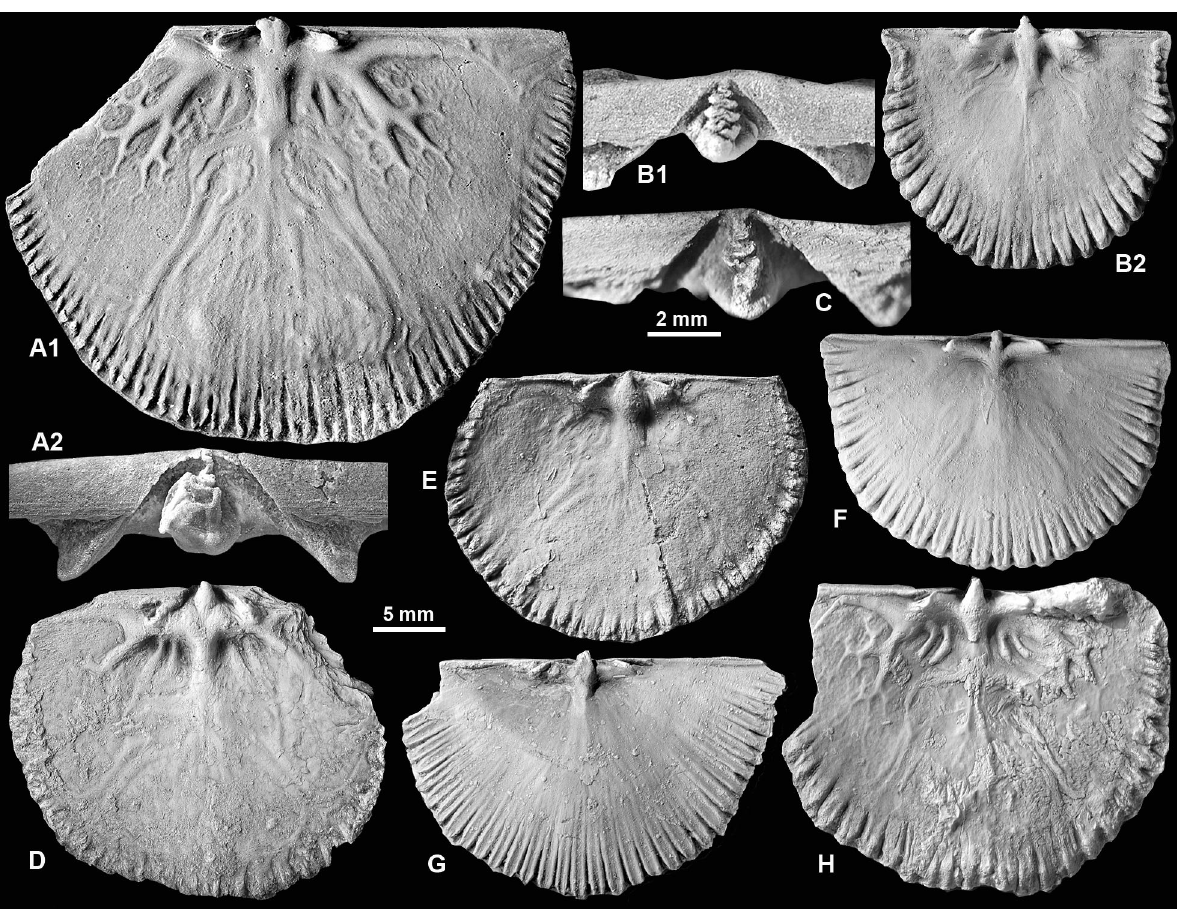
Fig. 4. A1 , A2 , Cyrtonotella kuckersiana kuckersiana (Wysogórski, 1900), interior and cardinal process of dorsal valve TUG 1054-15, Kohtla, northeastern Estonia, Kukruse Regional Stage (RS). B1 , B2 , Cyrtonotella laine (Öpik 1930a), posterior view of the cardinal process and interior of dorsal valve GIT 400-118, Pääsküla (western part of Tallinn), Jõhvi Substage of the Haljala RS. C , D , Cyrtonotella barbara (Öpik, 1930a), posterior view of the cardinal process and interior of dorsal valve GIT 400-78. Tallinn (Pirita–Ülemiste channel), Kukruse RS. E , Cyrtonotella barbara (Öpik, 1930a), interior of dorsal valve GIT 400-86, Tallinn? (locality HN 32), Kukruse RS. F , Cyrtonotella kuckersiana frechi (Wysogórski, 1900), interior of dorsal valve TUG 72-278, Alliku (western Estonia), Jõhvi Substage of the Haljala RS. G , Cyrtonotella kuckersiana frechi (Wysogórski, 1900), interior of dorsal valve TUG 243-151, Aluvere, northeastern Estonia, Haljala RS. H , Cyrtonotella kuckersiana kuckersiana (Wysogórski, 1900), interior of dorsal valve GIT 400-138, Alliku (western Estonia), Jõhvi Substage of the Haljala RS. Scale 5 mm for dorsal valve, 2 mm for cardinal